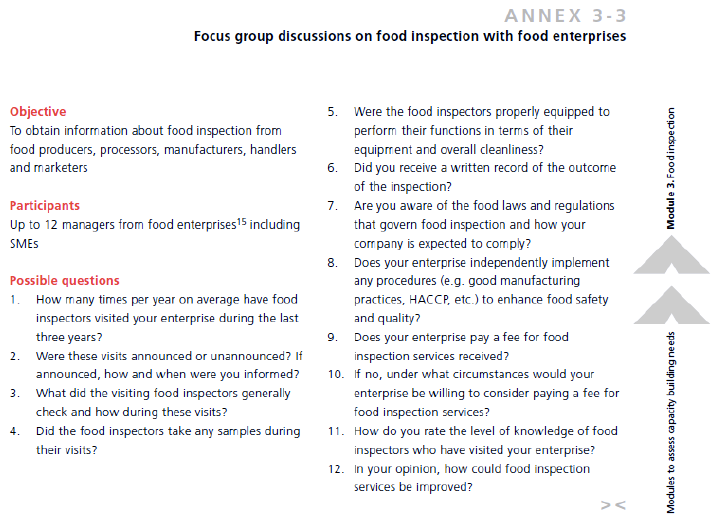
Figure A3. Discussion questions for industry representatives.